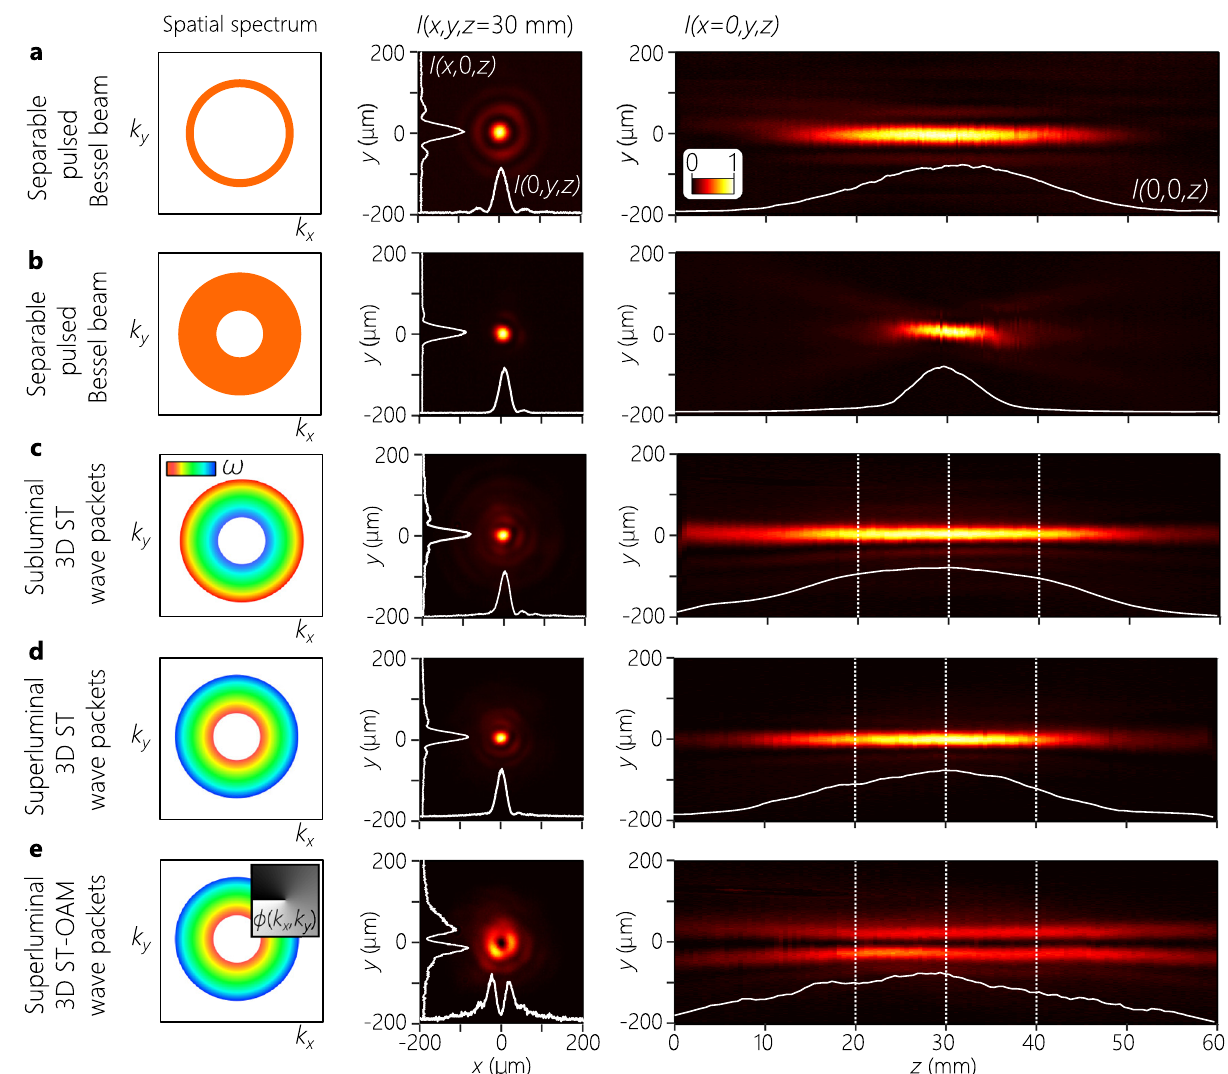
Δ λ =0.3nm. a A separablepulsedBessel beam with Δ k r =0.02 rad/ μ m. b A pulsed Bessel beam with Δ k r =0.07 rad/ μ m. c – e In all cases Δ k r =0.07 rad/ μ m as in b . c A subluminal ( e v = 0 : 83 c ) 3D ST wave packet; d a superluminal ( e v = 1 : 37 c ) 3D ST wave packet; and e a superluminal ( e v = 1 : 16 c ) 3D ST-OAM wave packet with ℓ =1 (the inset in the fi rst column is the associated transverse spectral phase dis- tribution). The dotted vertical white lines in the third column in c-e identify the axial planes for the time-resolved measurements in Fig.